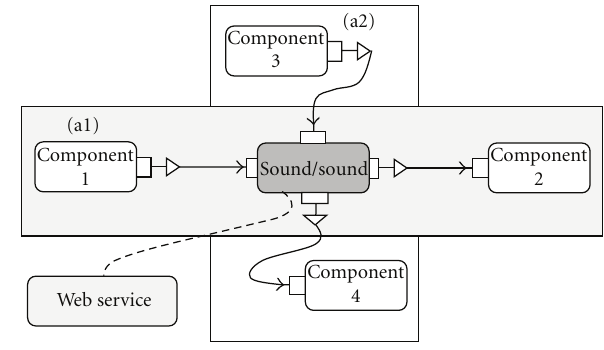
Figure 19: Example of a shared connector.